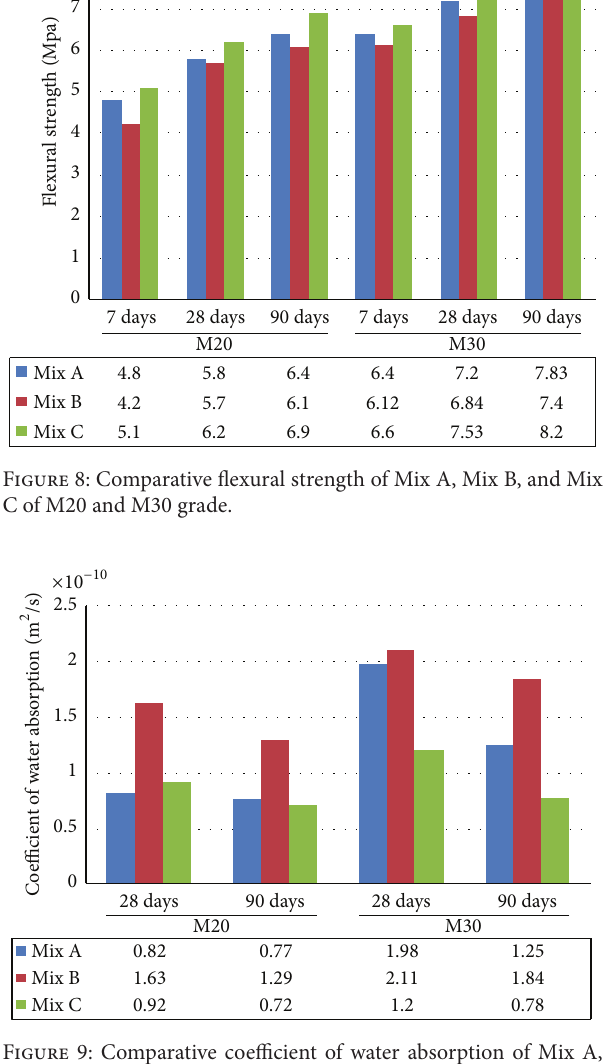
Figure 9: Comparative coefficient of water absorption of Mix A, Mix B, and Mix C of M20 and M30